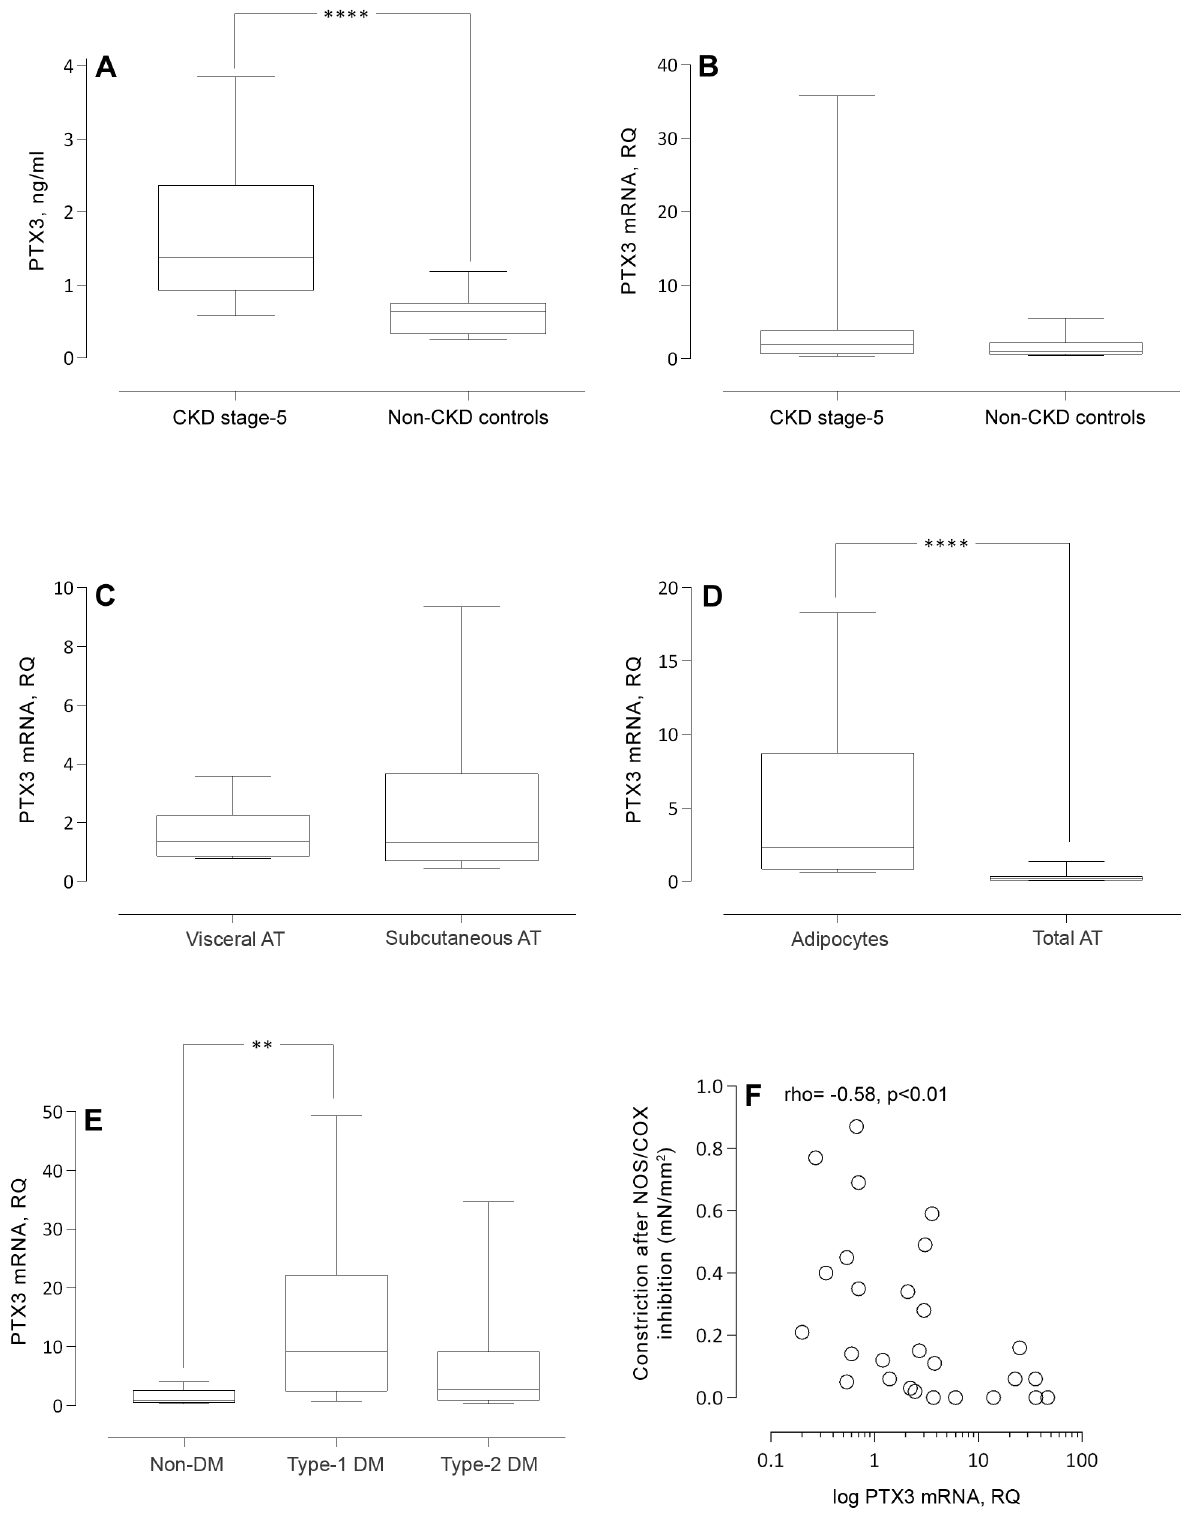
Figure 1. PTX3 mRNA is expressed in isolated adipocytes and levels correlate with endothelial dysfunction in CKD patients. (A) Plasma PTX3 concentrations (ng/ml) measured in 39 non-CKD controls and 53 patients with CKD stage 5. PTX3 mRNA quantities (relative quantity, RQ, arbitrary units) analysed in (B) abdominal subcutaneous adipose tissue of 40 non-CKD controls and 56 patients with CKD stage 5, (C) subcutaneous and visceral fat depots obtained from 20 non-CKD patients, (D) isolated adipocytes and intact adipose tissue (n=14) as well as in (E) patients with CKD stage 5 and no diabetes mellitus (n=35), diabetes mellitus type 1 (n=8) or diabetes mellitus type 2 (n=13). (F) Negative correlation (Spearman’s rank) between subcutaneous adipose tissue PTX3 mRNA quantities (log transformed) and constriction (basal tone) after nitric oxide synthase (NOS)